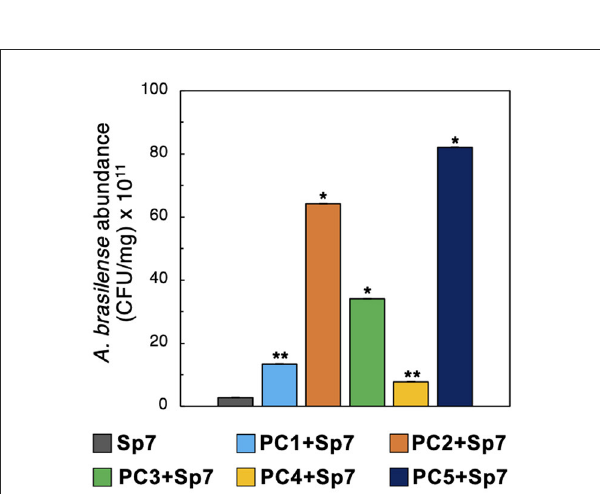
FIGURE7 Sp7 abundance in maize roots. Sp7 abundance (CFU/mg root) on maize roots inoculated with Sp7 only or co-inoculated with Sp7 and promoter consortia (PC1-PC5). ( * Wilcoxon Rank test: p -value < 0.01; ** Wilcoxon Rank test: p -value < 0.05). n = 3 replicate